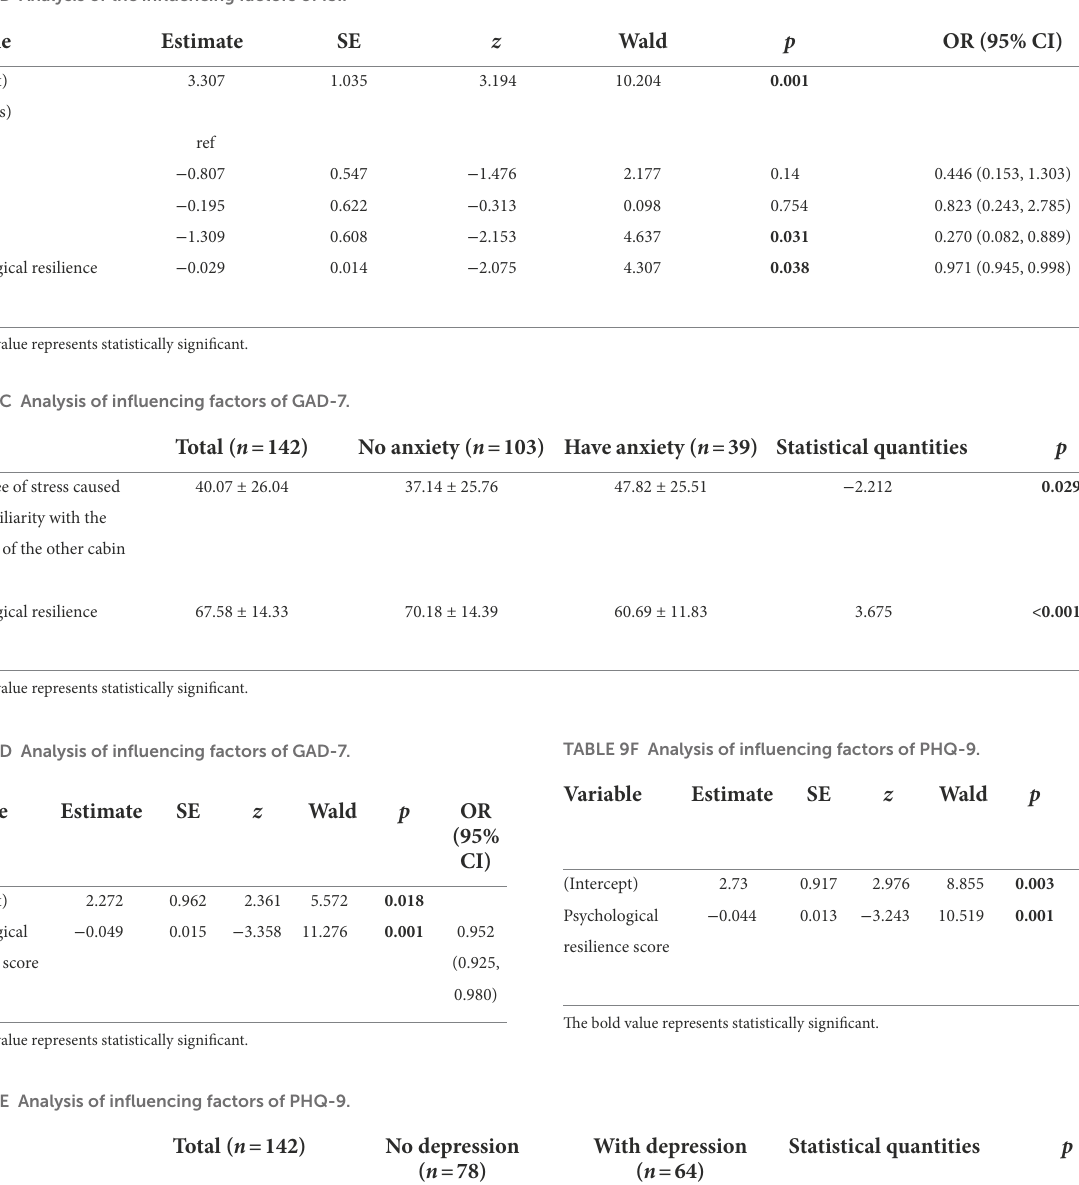
TABLE 9B Analysis of the influencing factors of ISI.